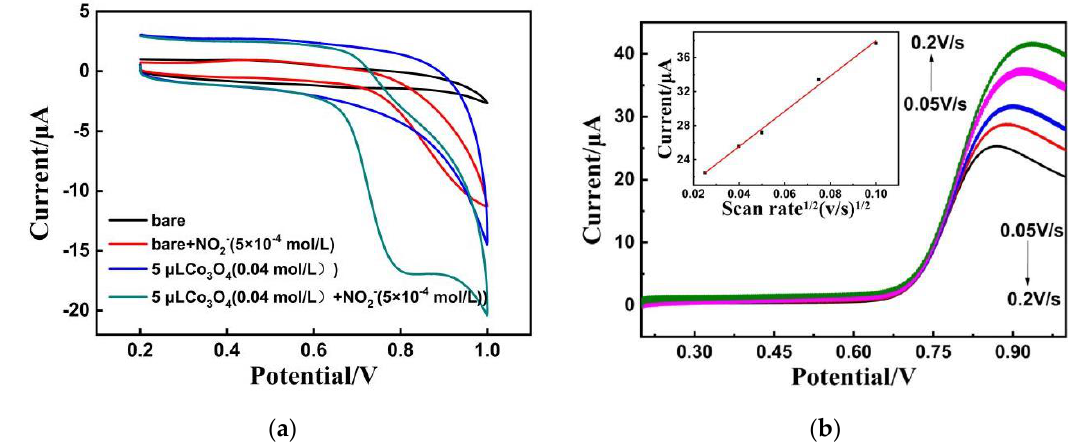
Figure 4. ( a ) CVs of bare electrode and GCE modified with ordered mesoporous CoO x /C-0.2 nanocomposites in 0.1 M PBS (pH = 3.5) at 0.8 V potential (1: bare electrode; 2: bare electrode with 0.5 mM nitrite; 3: CoO x /C@GCE; 4: CoO x /C@GCE with 0.5 mM nitrite). ( b ) DPVs of CoO x /C@GCE in 0.1 M PBS (pH = 3.5) and 1 mM nitrite at 0.8 V potential with scan rate from 0.05 to 0.2 V·s −1 .